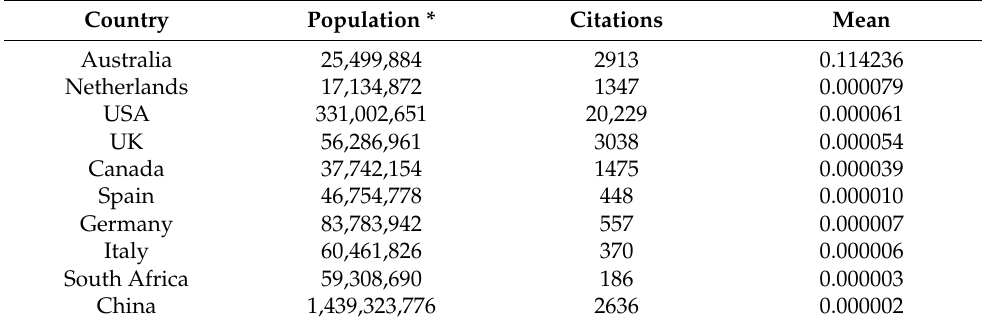
Table 3. Mean citations per